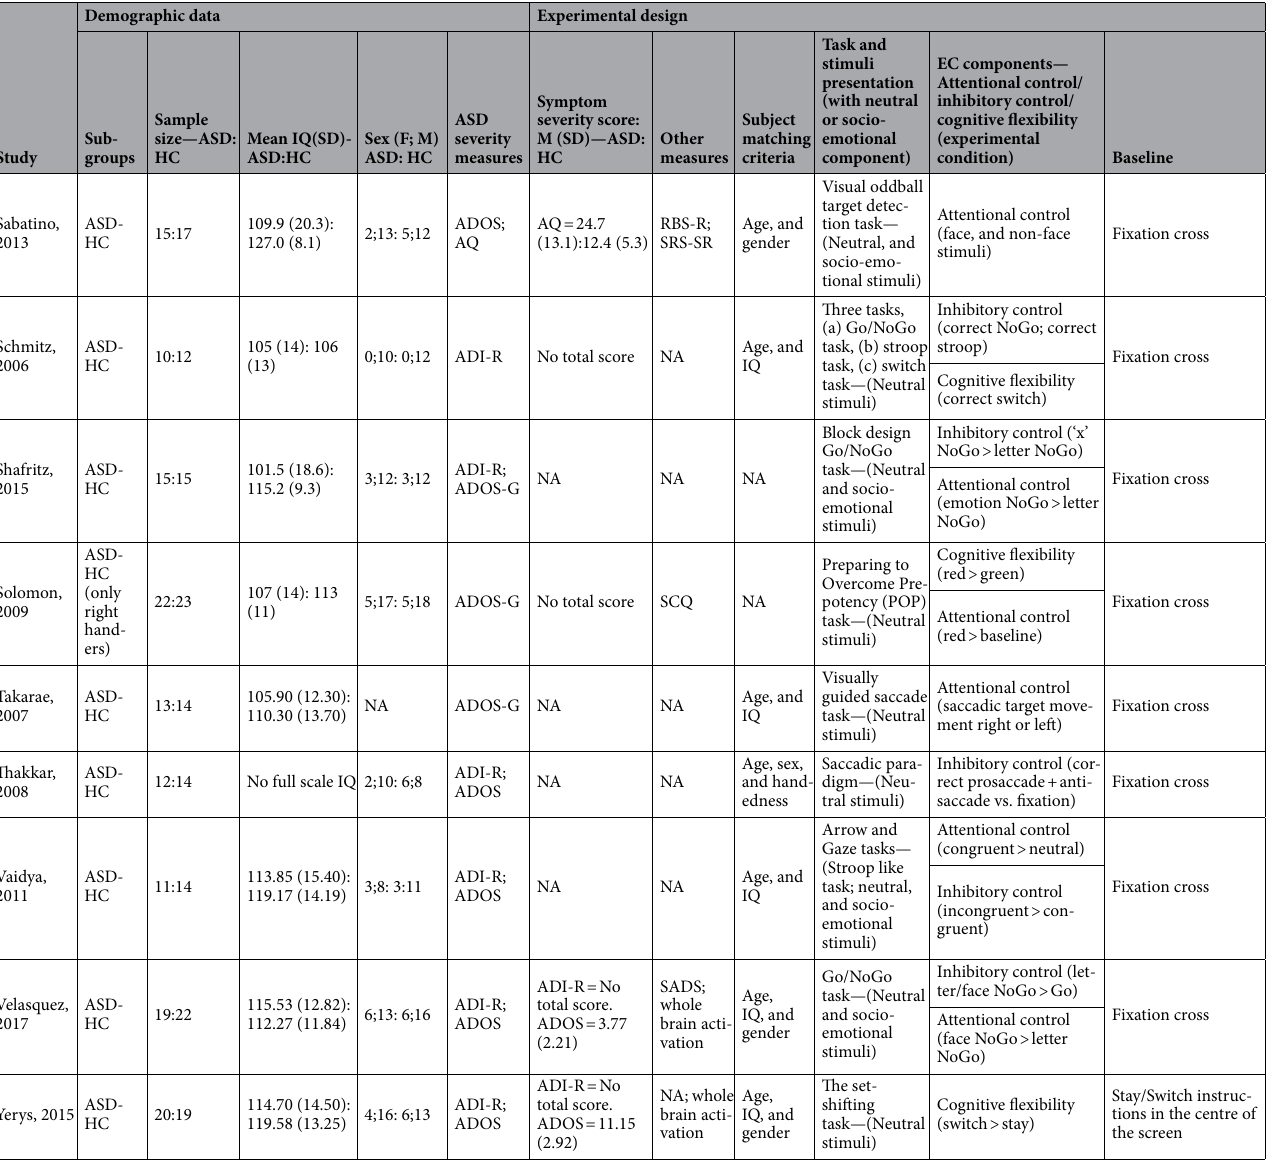
Table 1. fMRI studies (22 studies; 40 experiments) included in the meta-analysis. ASI (NEPSY-II) animal sorting and inhibition subtests from NEPSY-II, BRIEF behaviour rating inventory of executive function, SCQ social communication questionnaire, DISC-IV diagnostic interview schedule for children, DAWBA development and well-being assessment, RBS-R repetitive behaviour scale—revised questionnaire, DISCO diagnostic interview for social and communication disorders, HADS hamilton anxiety and depression scale, SADS social avoidance and distress scale, TEA-Ch test of everyday attention for children, TMT trail making